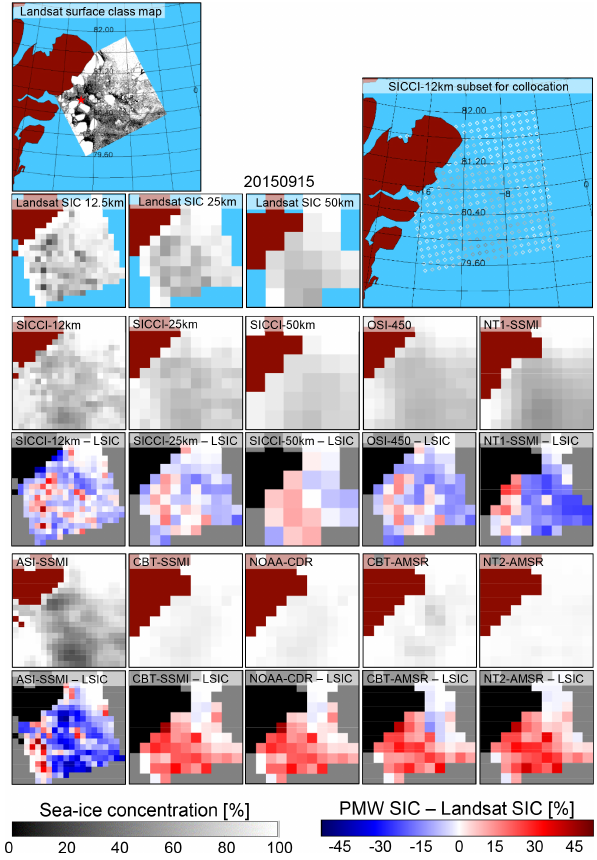
Figure 6. Landsat SIC, PMW SIC, and the difference PMW SIC minus Landsat SIC for all 10 products for a scene near the coast dur- ing freeze-up in Pine Island Bay, Amundsen Sea, Southern Ocean, on 12 March 2014. The red star in the top left map marks the lo- cation of the Pine Island Glacier Automatic Weather Station (see text). Some of the white patches near the coast in this map are actu- ally glacier ice not adequately flagged by the land mask. See Fig. 5 for more